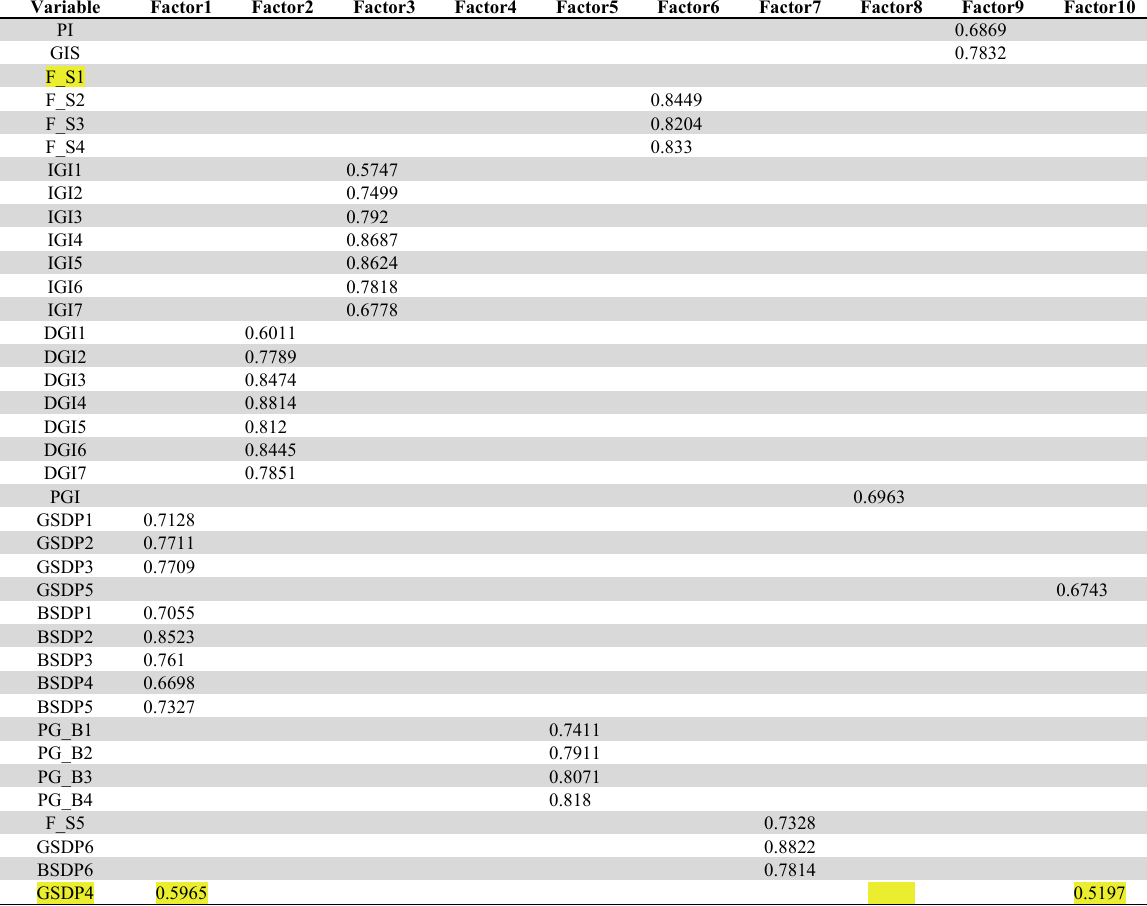
Results of grouping factors by the matrix of rotation factor loading groups affecting green investment